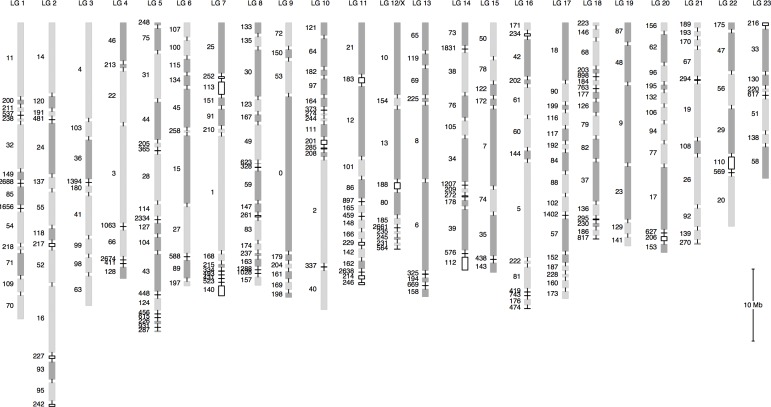
Distribution of anchored scaffolds along linkage groups.Grey outlined boxes denote scaffolds with at least two markers. Scaffolds in the forward orientation are solid grey and in the reverse orientation are dashed light grey. Black outlined boxes and horizontal black bars denote scaffolds with just one marker and unknown orientation. Spacing between scaffolds was set arbitrarily to 500 kb.